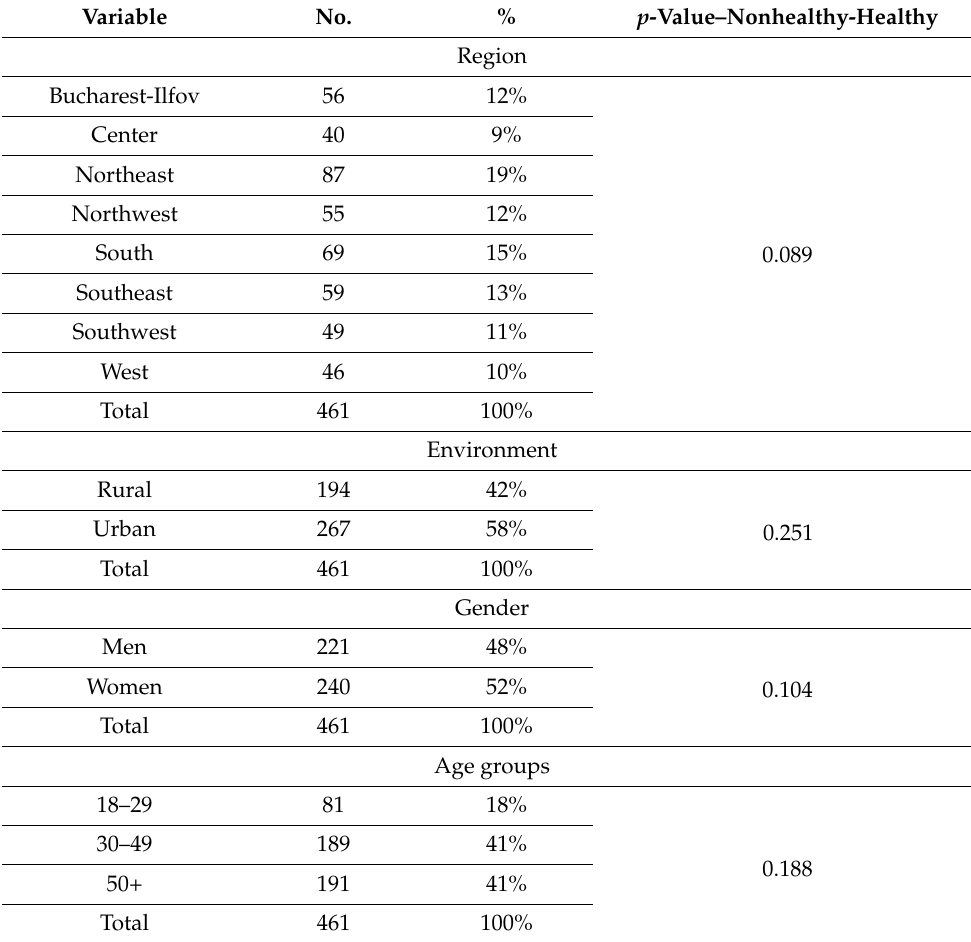
Table 2. Demographic characteristics depending on the presence of psoriasis